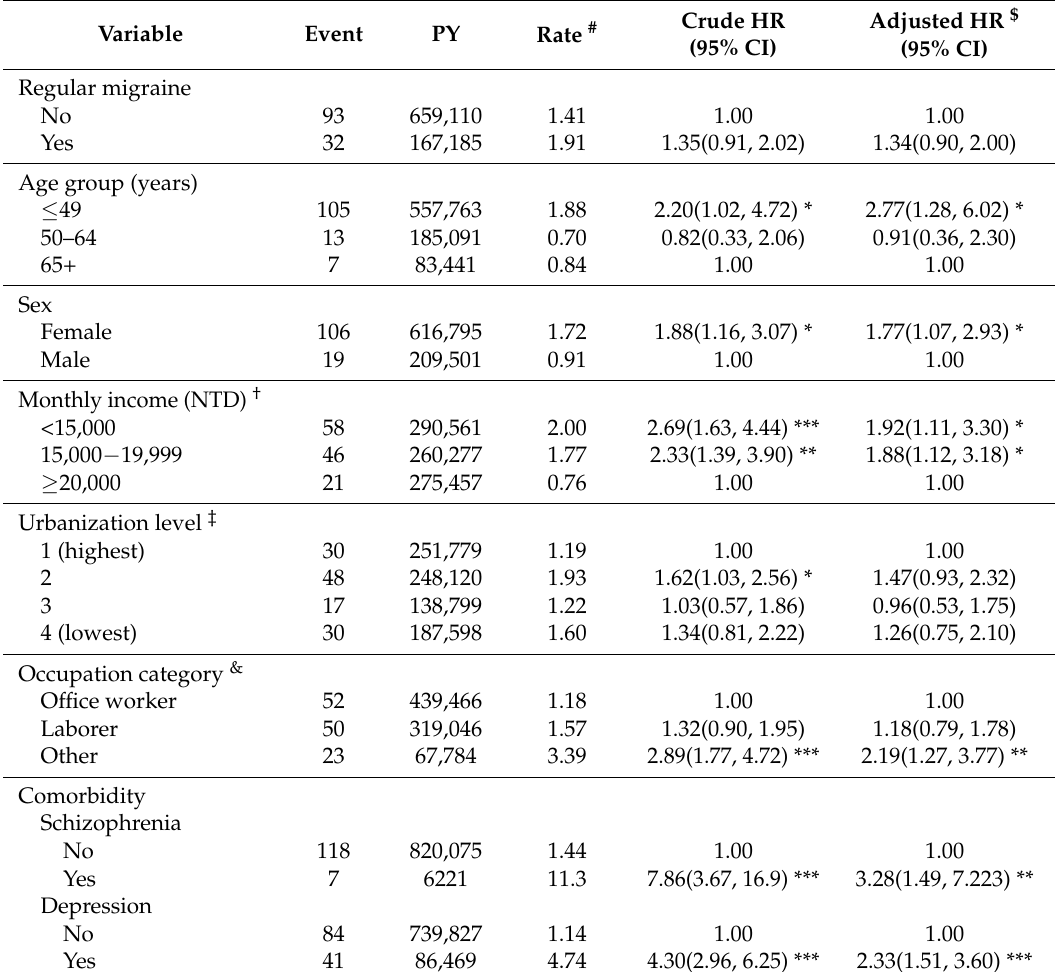
Table 3. Incidences and risk factors for suicide attempt with or without regular